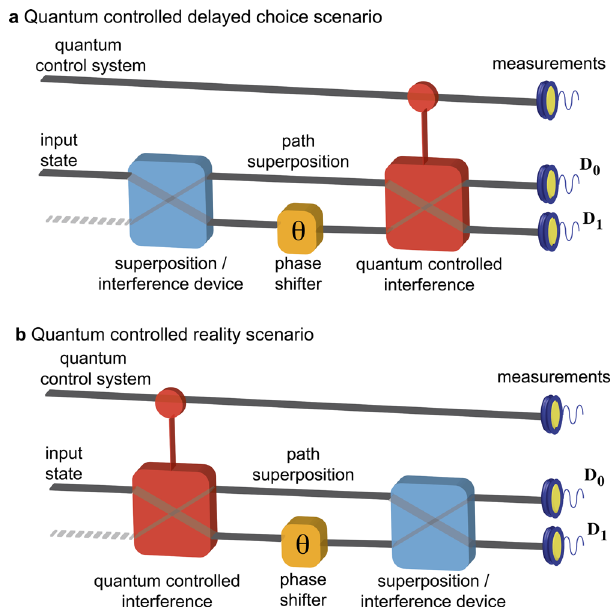
Fig. 1 Schematic circuits of quantum controlled interferometers. The blue boxes represent unitary operations which here play the role of superposition devices---the quantum network equivalent of a beam-splitter. Using an ancillary qubit in superposition (quantum control system), we implement the quantumly controlled unitary superposition device (represented by the red boxes). a Original version of the quantum delayed- choice experiment, where the second beam-splitter is prepared in a coherent superposition of being in and out of the interferometer (con fi gurations closed and open , respectively). b Our proposal for a quantum controlled reality experiment. Here, the fi rst beam-splitter is submitted to quantum control. Although the measurement outcomes yield the same visibility in both of these experimental arrangements, the realism aspects inside the interferometer are crucially